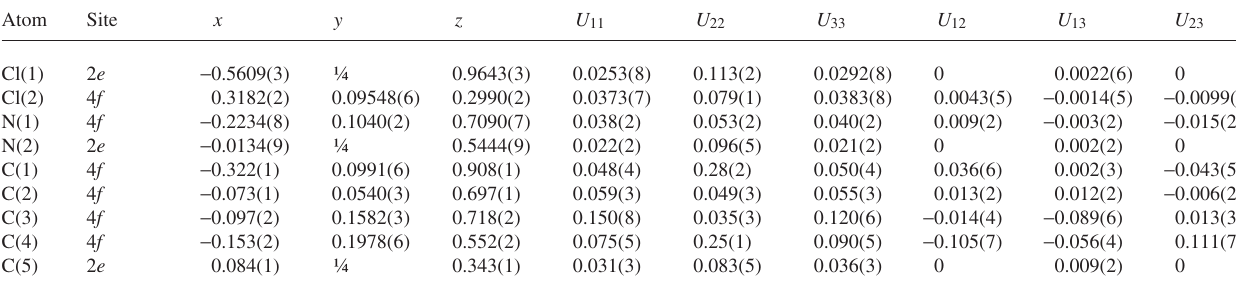
Table 3. Atomic coordinates and displacement parameters (in Å 2 ) .